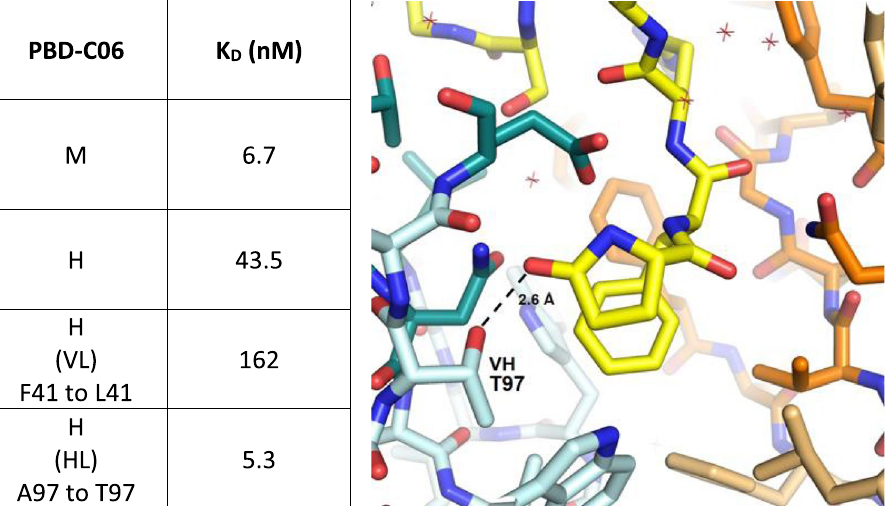
Figure 2. VH chain interaction with pE3-A β (3–12). Binding strength of murine (M), humanized (H) PBD- C06 and two designed framework mutations were determined by Biacore (left). Molecular interactions of the pyroglutamate ring at the N-terminus of pE3-A β (3–12) of the VL chain (yellow stick) with the hydroxyl group of T97 (cyan stick) within the murine VH chain are shown on the right as determined in 45 . The distance between T97 of the VH chain and the pyroglutamate ring of pE3-A β (3–12) is shown as a dashed line.